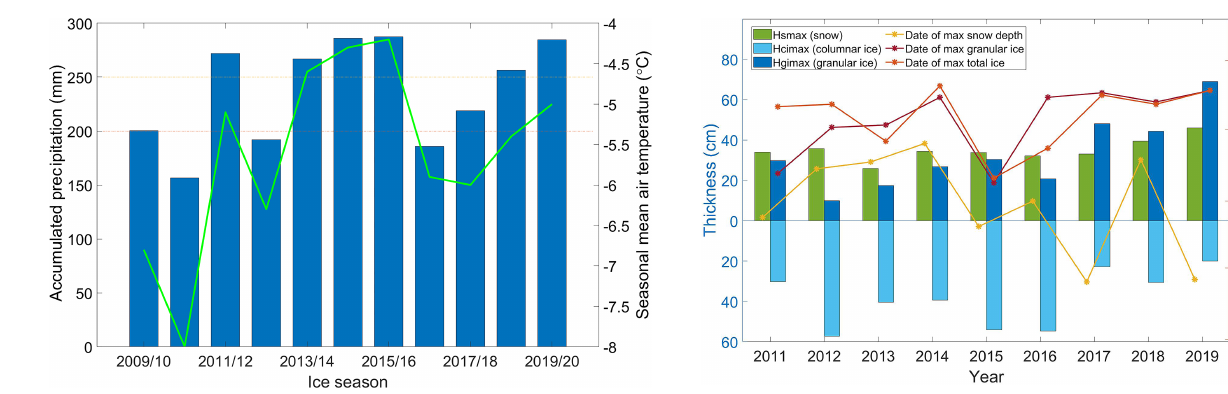
Figure 8. The accumulated total precipitation and mean air temper- ature between 1 November and 31 May.